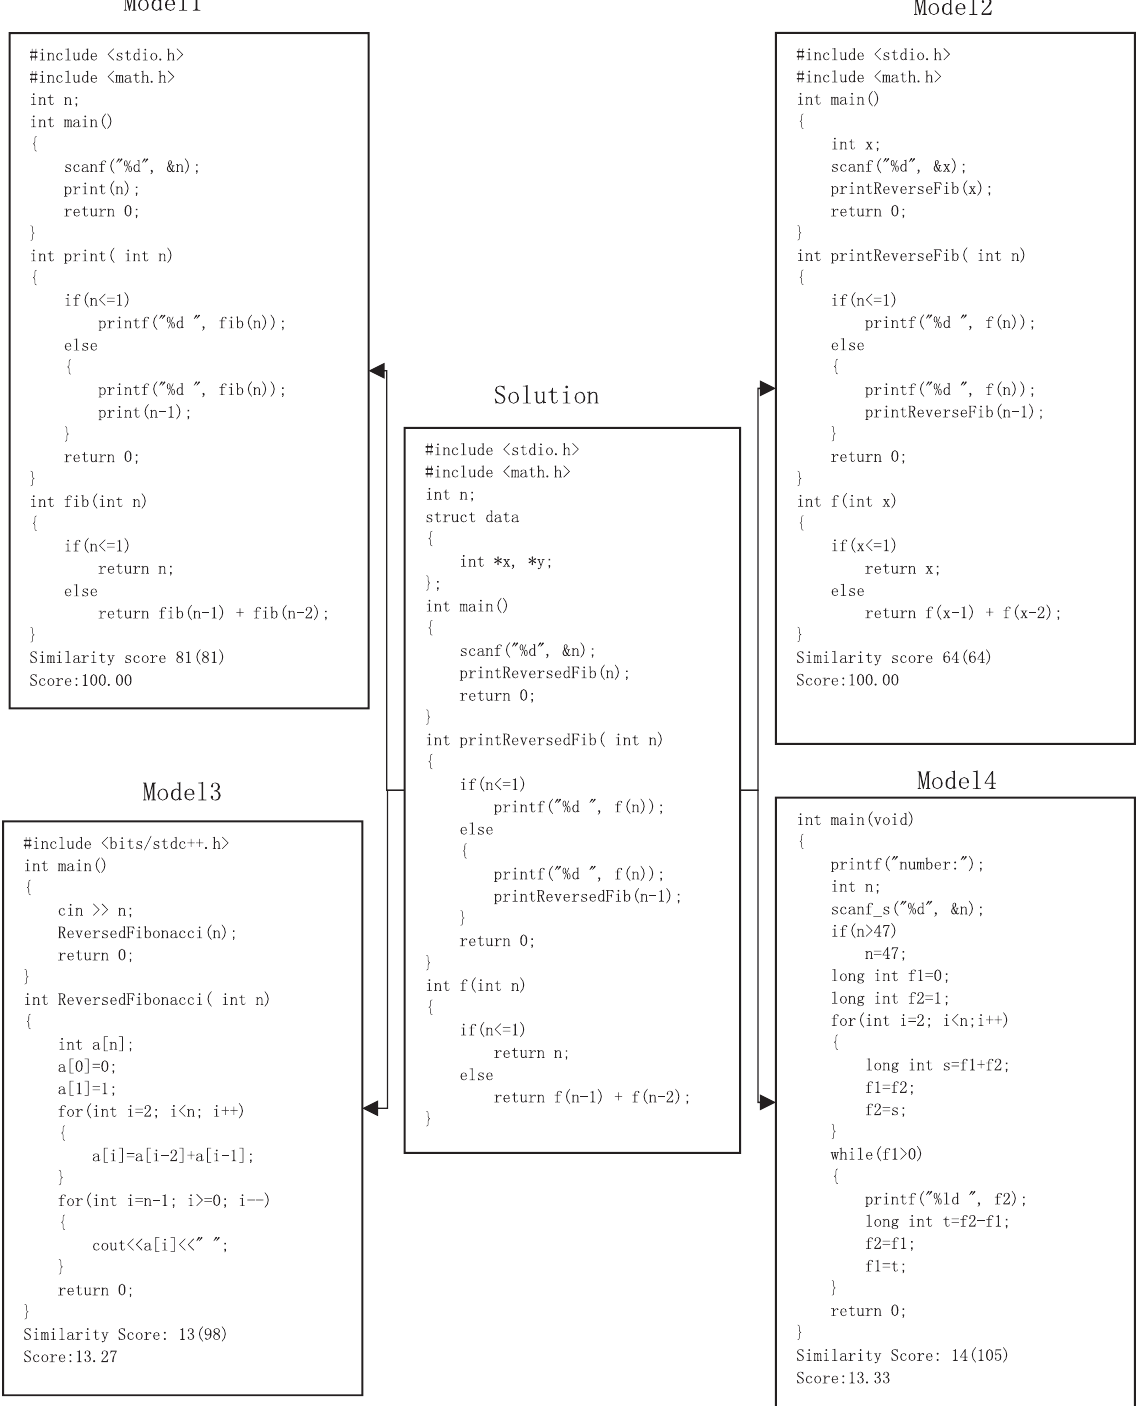
Figure 4: Feedback result of program matching trace